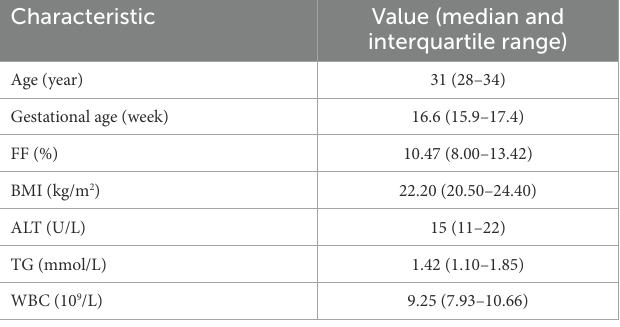
TABLE 1 Sample characteristics of the study population ( n = 4,281) Characteristic